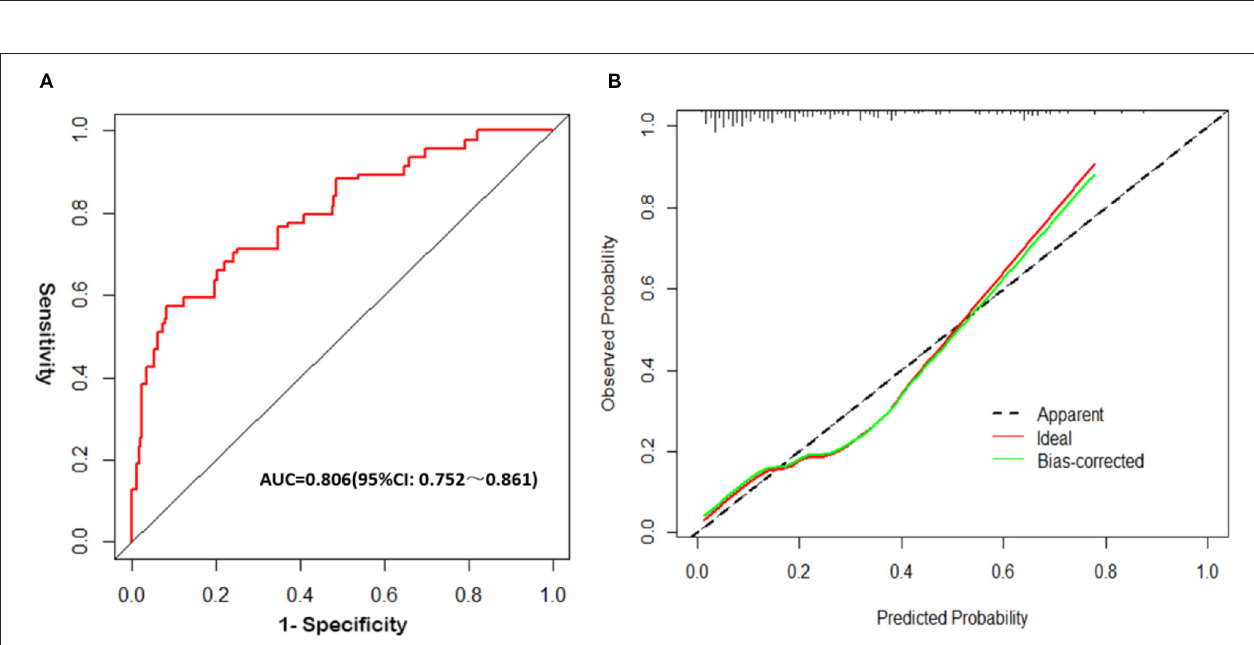
FIGURE 3 | Validation of the nomogram. (A) The receiver operating characteristic (ROC) curve analysis of the nomogram; (B) Calibration curves of the nomogram.